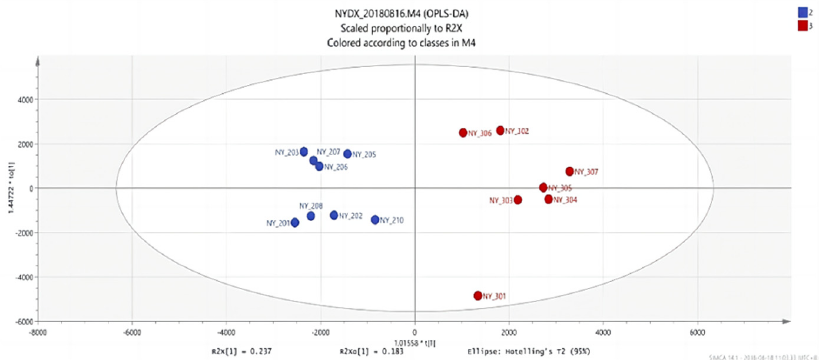
Figure 7. OPLS-DA score plots between group 2 and group 3.